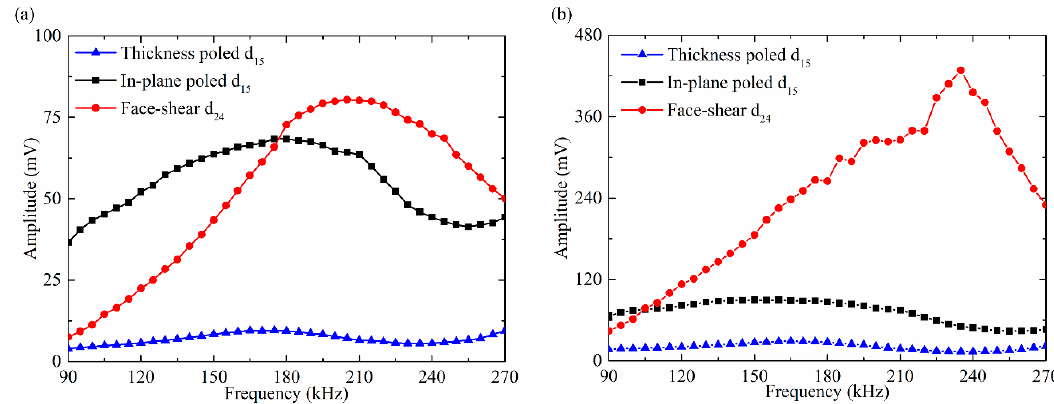
Figure 10. The SH 0 wave amplitude versus frequency. Signals were generated and received by the same type shear mode piezoelectric wafer under ( a ) fixed drive voltage of 20 V, ( b ) fixed power consumption of 0.08 W.